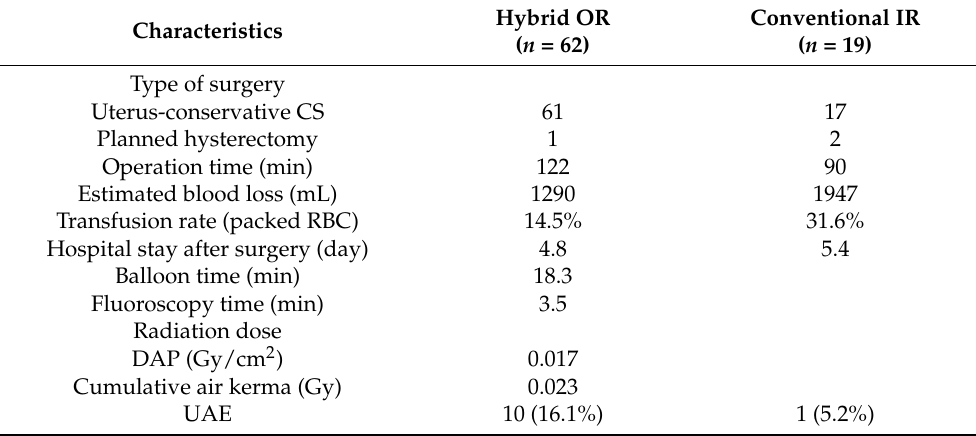
Table 2. Peripartum outcomes of patients with placental abnormality managed by